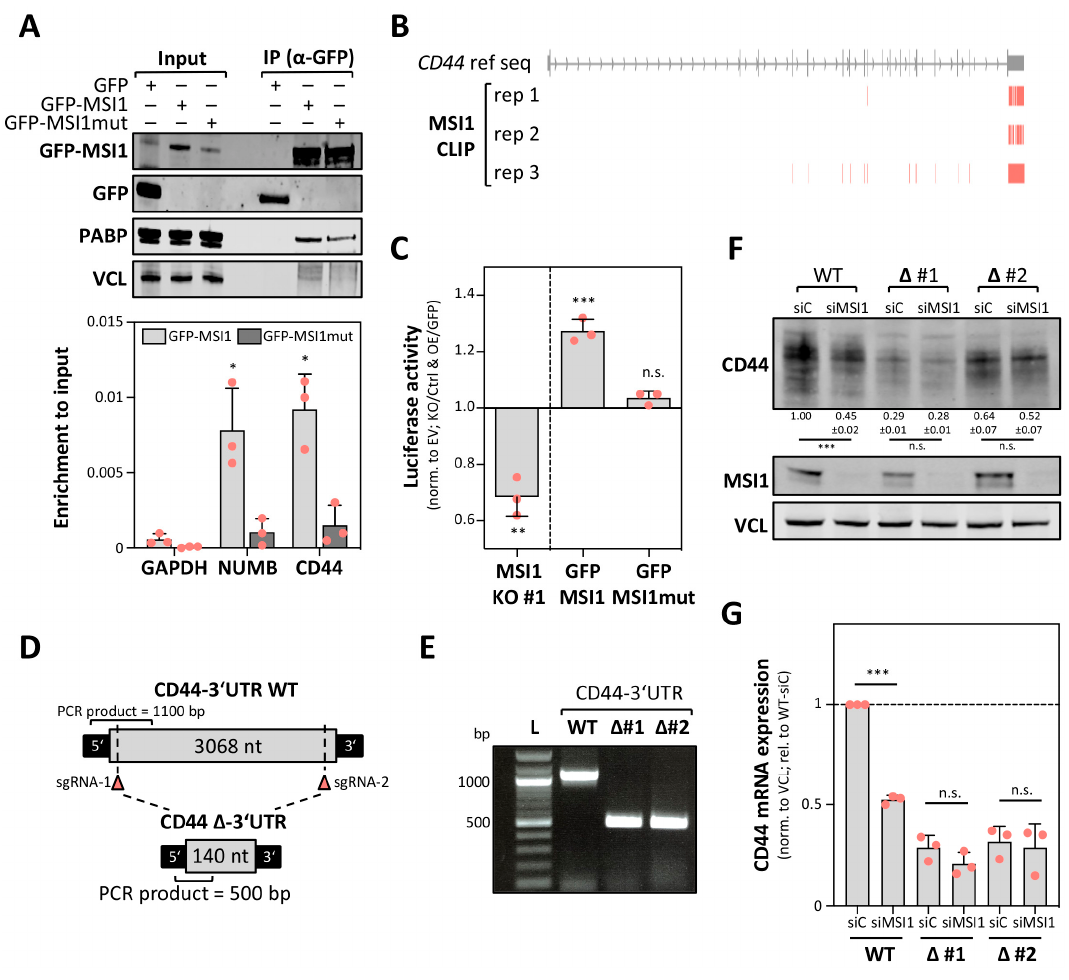
Figure 4. MSI1 promotes CD44 expression in a 3 ′ UTR-dependent manner. ( A ) Representative Western blot analysis (upper panel) of the indicated proteins and RT-qPCR analyses (lower panel) of mRNAs co-purified with GFP, GFP-MSI1 or RNA-binding-deficient GFP-MSI1mut by immunoprecipitation. The enrichment of the indicated mRNAs is shown upon input